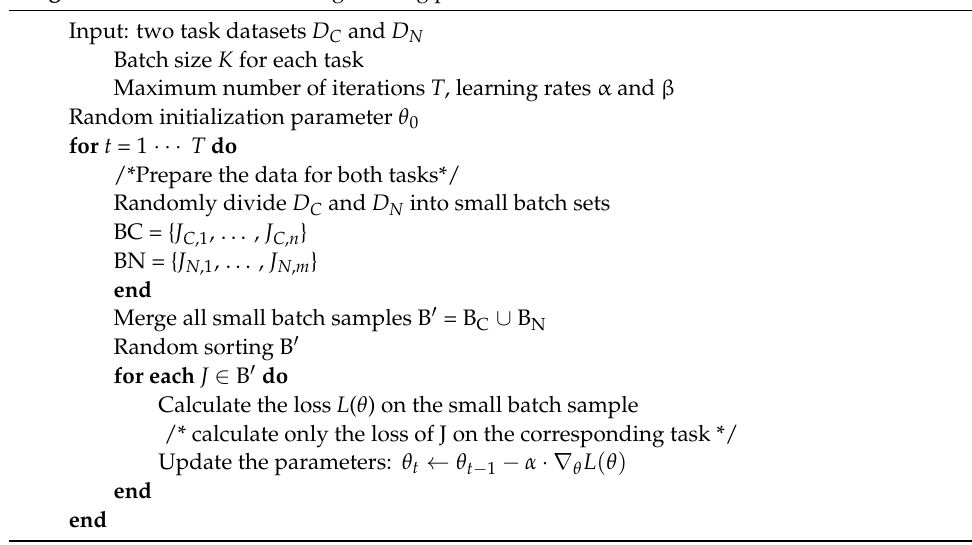
Algorithm 1 Multi-task learning training